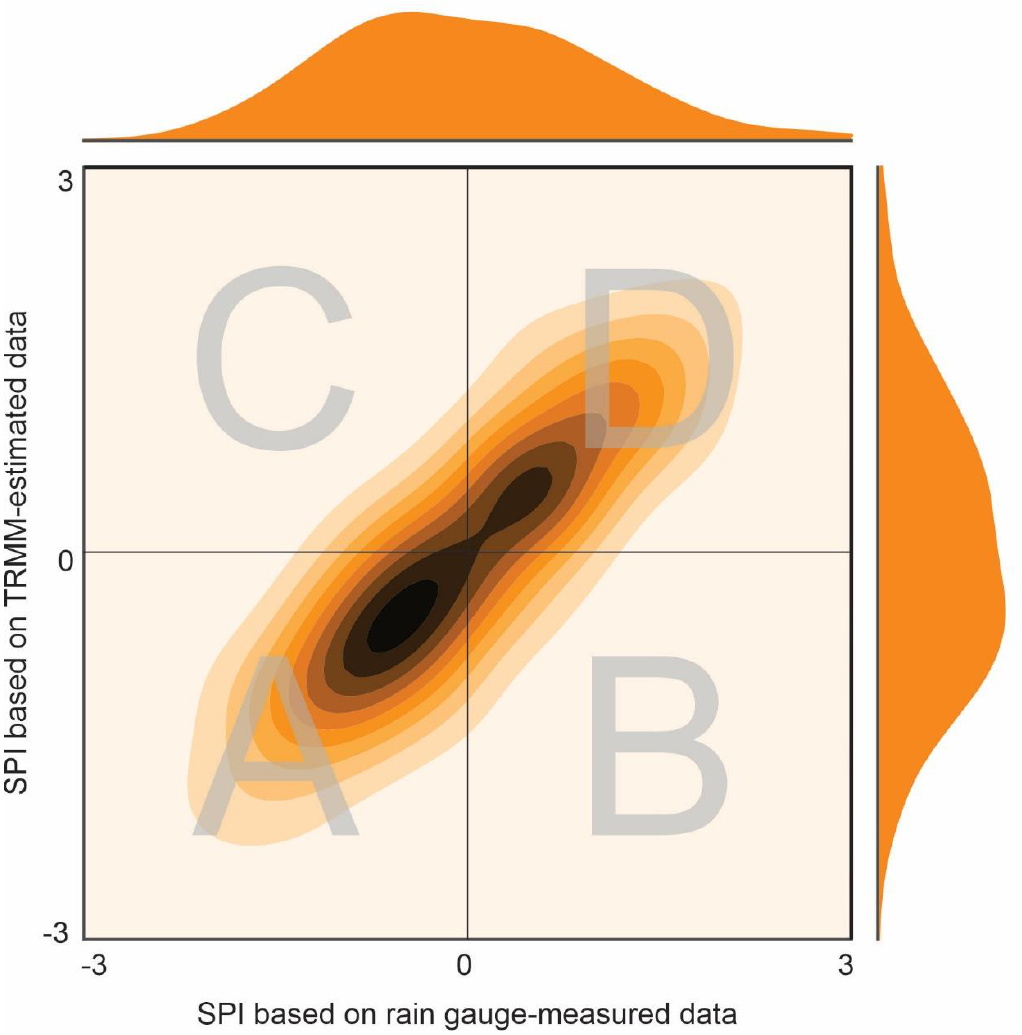
Figure 3. Contingency table applied to assess the performance indices ( PC , POD , FAR and CSI ) based on the two-dimensional kernel density estimate plot. Table 1. Details of the evaluation metrics.